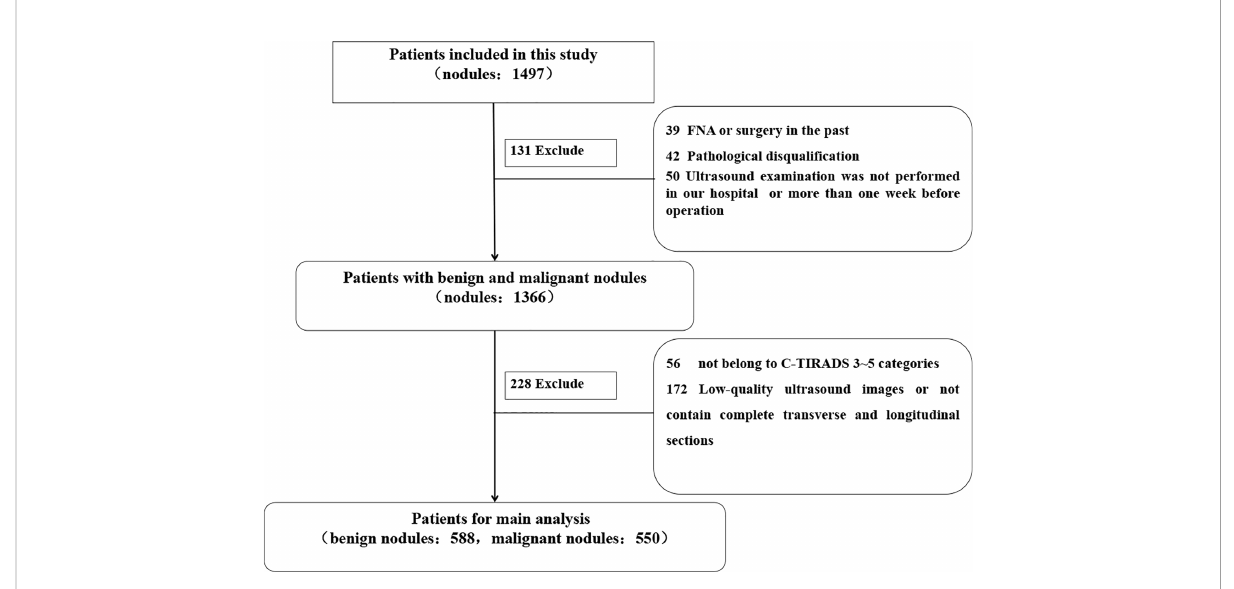
FIGURE 1 Flowchart of enrolling patients with thyroid